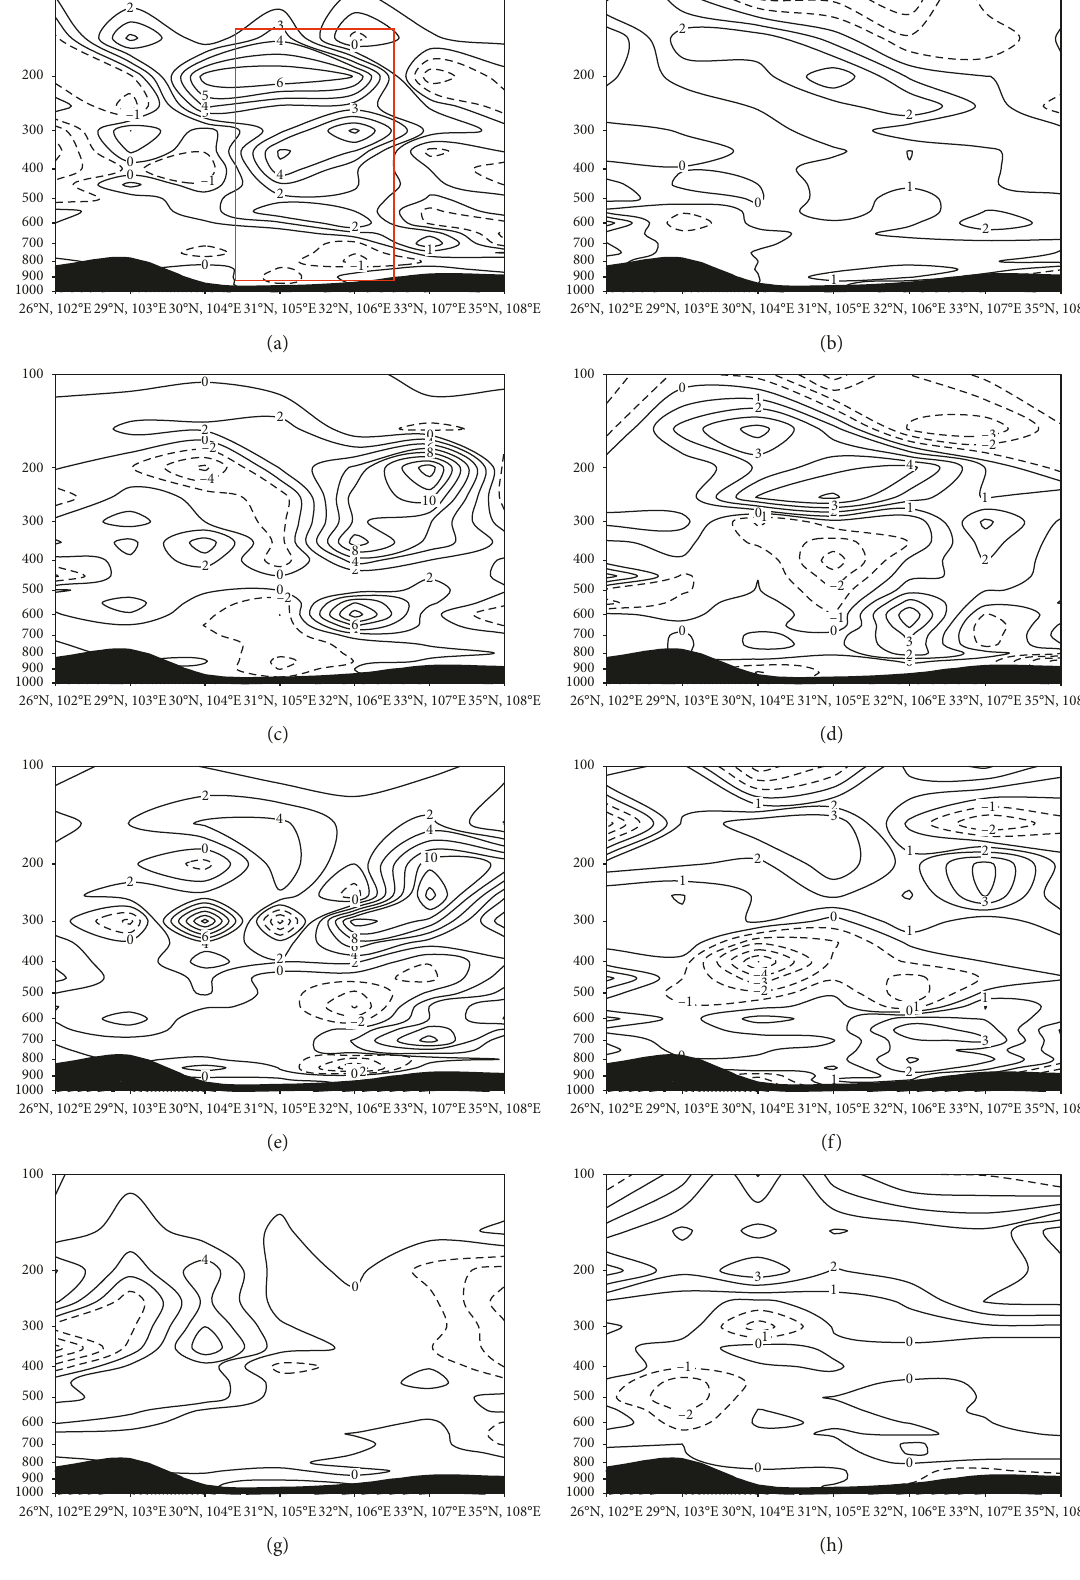
Figure 10: Cross section of vorticity advection (a, c, e, g) and PEPT advection (b, d, f, h) along line A-A terrain) at (a, b) 0000 UTC 27 October 2014, (c, d) 0600 UTC 27 October 2014, (e, f) 1200 UTC 27 October 2014, and (g, h) 0000 UTC 28 October 2014. In (a) red box area represents rainstorm